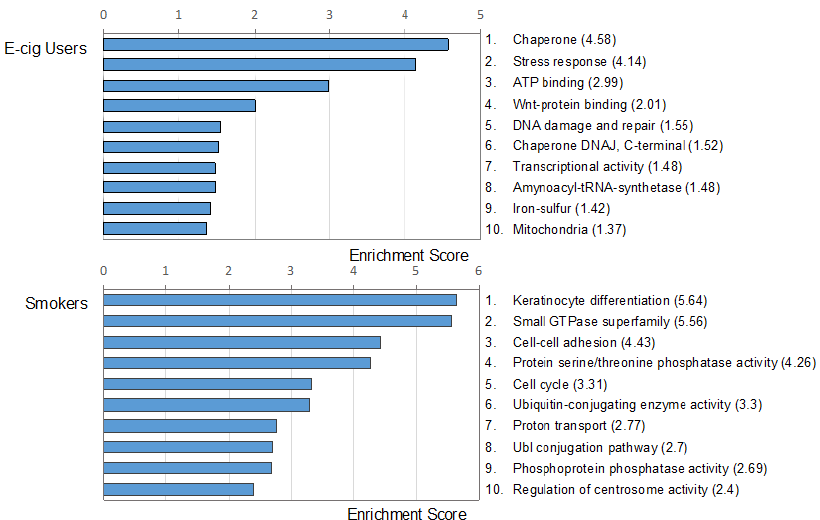
Figure 5. Gene ontology analysis of the differentially expressed genes in e-cig users and smokers relative to controls by Database for Annotation, Visualization and Integrated Discovery (DAVID). The top ten functional clusters in e-cig users and smokers are shown. Enrichment scores are indicated in parentheses.